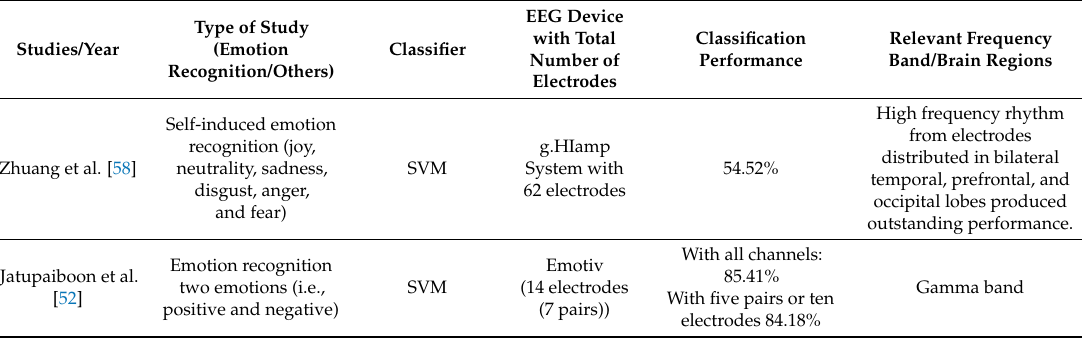
List of studies using EEG signals to perform emotion recognition and other